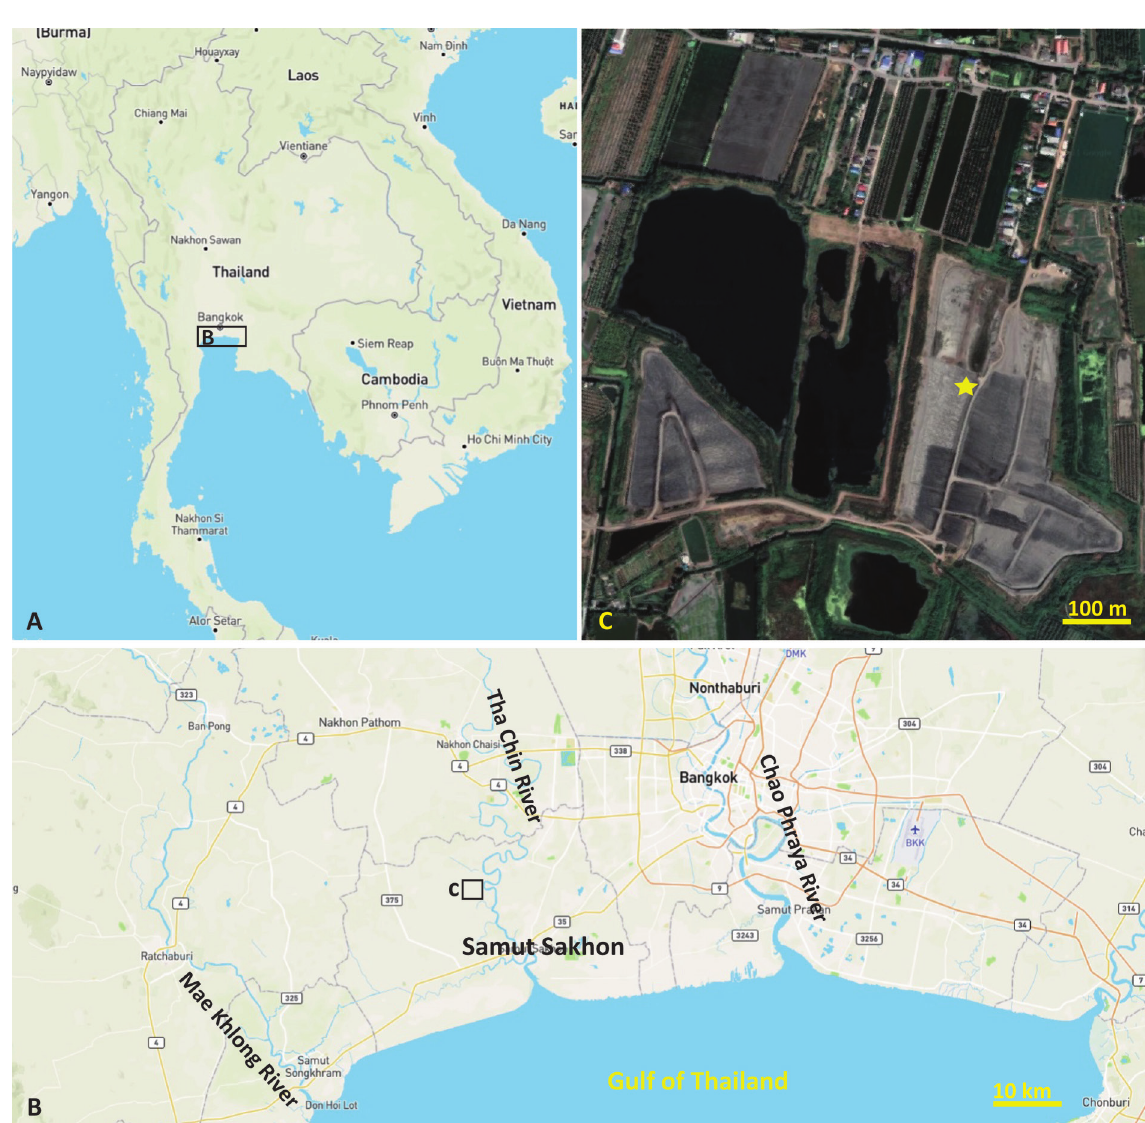
Fig. 2. Map of the studied section. A–B . Position of the study area at the northern coast of the Gulf of Thailand. C . Location of the whale-fall excavation site in Samut Sakhon Province (Google Map,